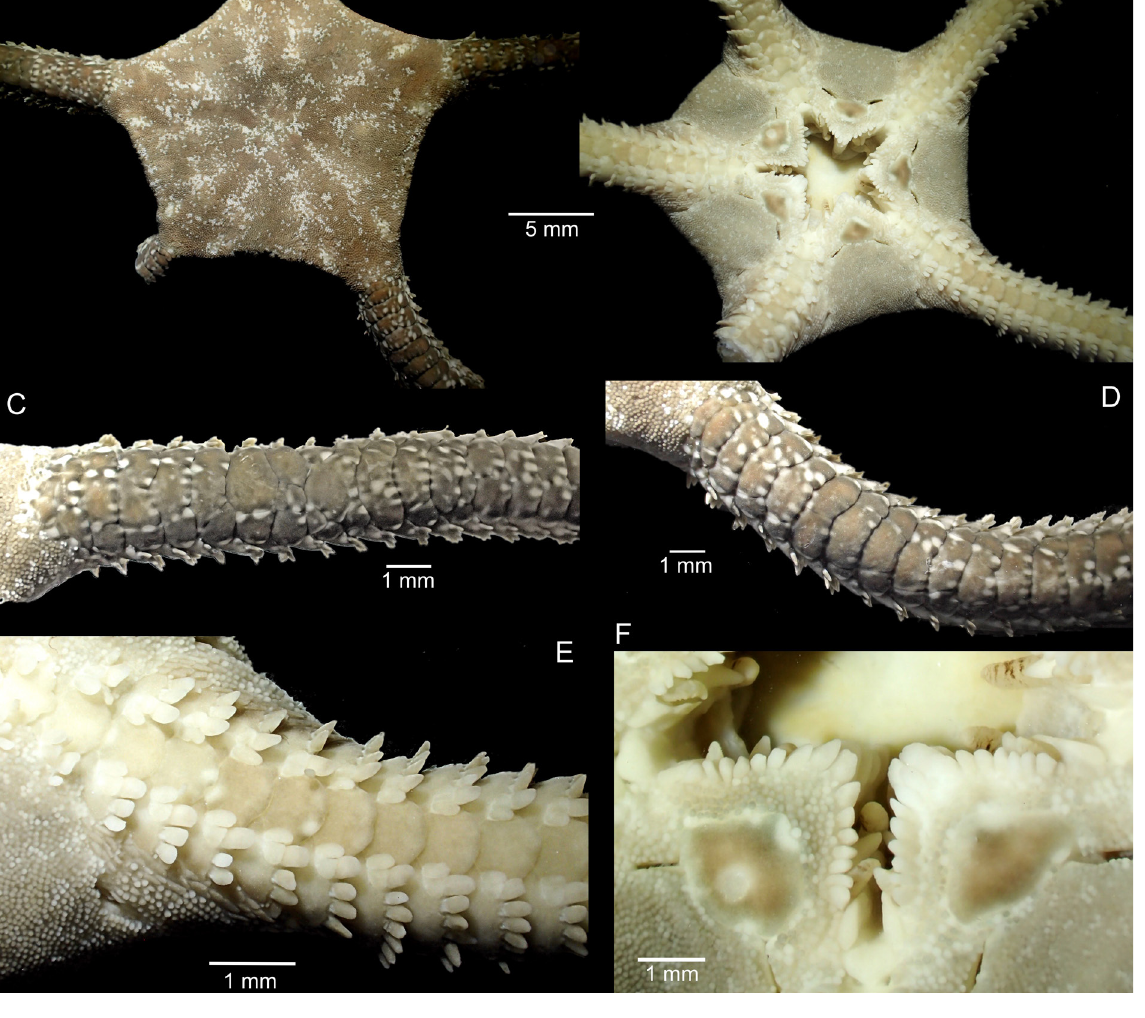
Fig. 9. Ophioderma hybrida sp. nov., holotype (SMNH-Type-9185), digital images. A . Dorsal aspect. B . Ventral aspect. C – D . Two dorsal arms, note the multiple dorsal plates. E . Ventral arm. F .